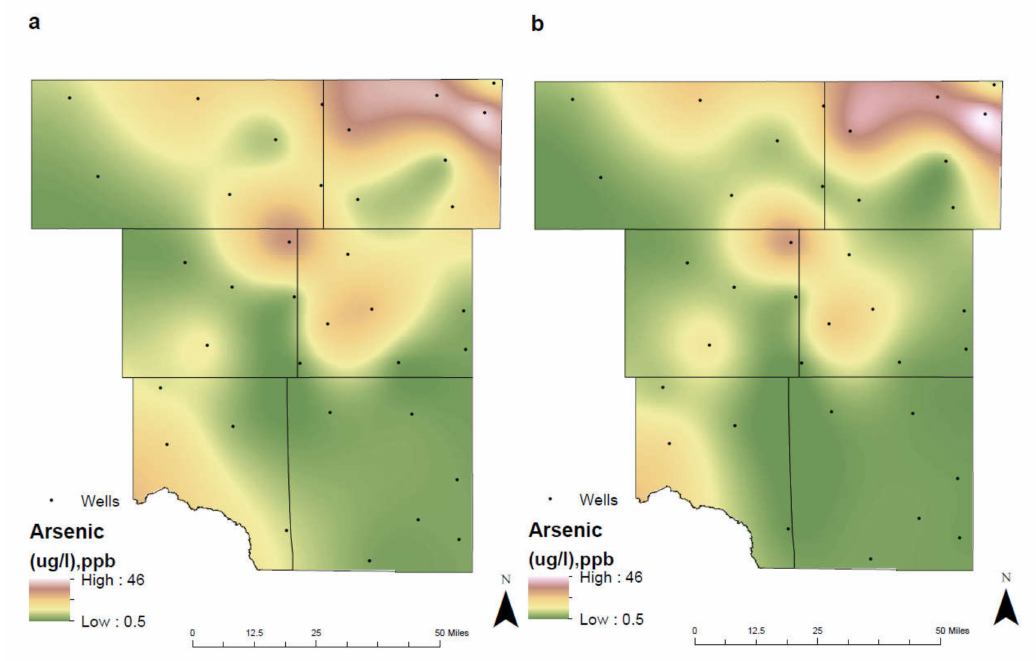
Figure 10. Spatial distribution of arsenic in the study are for ( a ) 1992–2005 and ( b )